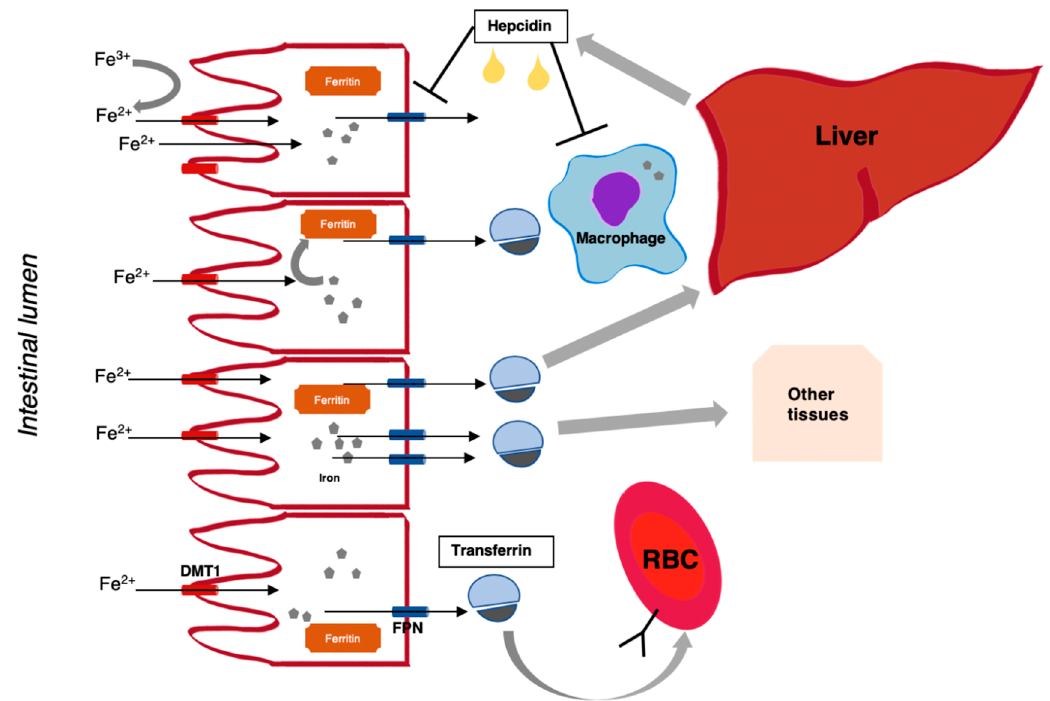
Figure 1. Overview of iron physiology. Non-haem iron (after reduction to Fe 2 + by membrane-bound enzymes), originating from dietary intake (mostly Fe 3 + ), enters the enterocyte of the proximal intestine via the divalent metal transporter (DMT1), and exits the cell on the basolateral side through ferroportin (FPN), which is potentiated by an oxidase, hephaestein. Depending on the state of iron need, iron can be released from the cell or sequestered in the form of ferritin (a measure of body iron stores). Iron is bound by transferrin in plasma, which enables transport and distribution to other body tissues (this also depends on the presence of transferrin receptors). Hepcidin, which is a peptide hormone produced by the liver, negatively regulates iron absorption and release from cells (e.g., macrophages) depending on iron need.